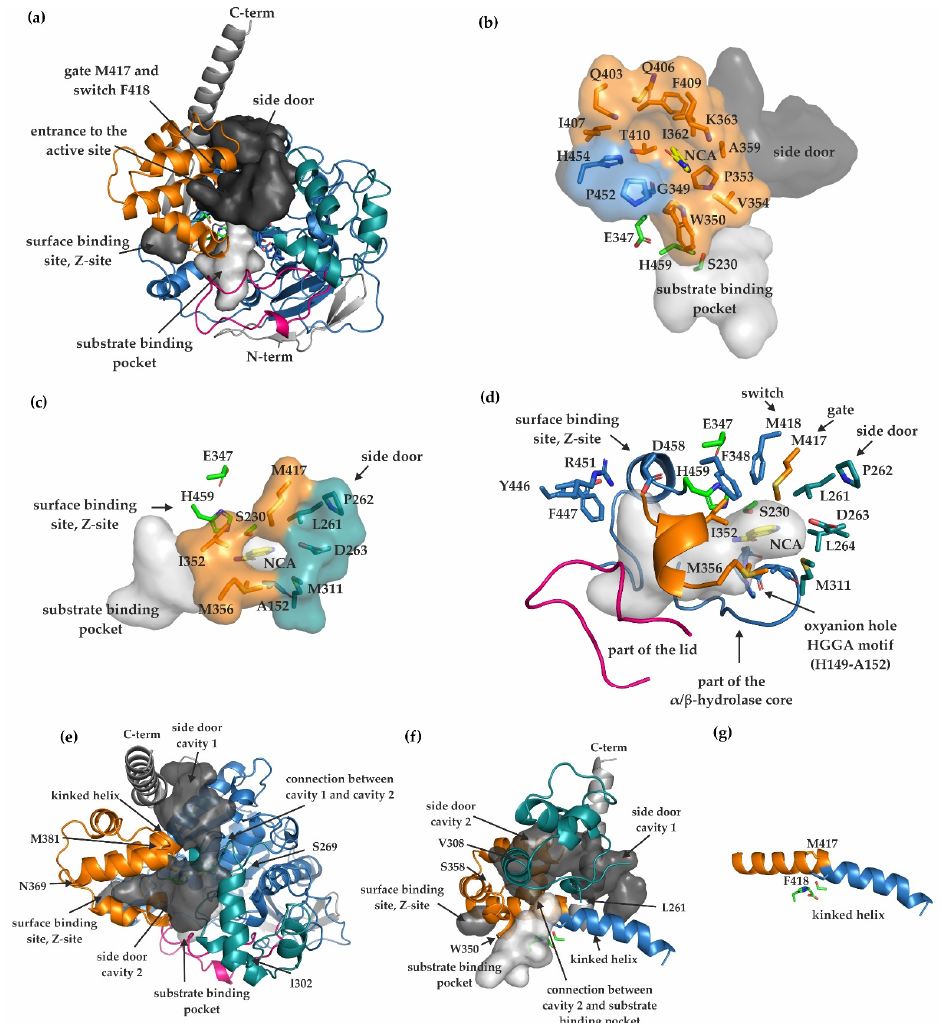
Figure 3. Binding pockets and conserved sites of mCes2c. ( a ) Substrate binding pocket (light gray), side door (dark gray) and surface binding site (Z-site, gray) are formed by mCes2c. The structure is shown in the same orientation as in Figure 2b. ( b ) Surface binding site (Z-site) of mCes2c (chain B) with residues sculpting the site colored according to their underlying modules (RD in orange, cap in teal, α / β -hydrolase core in blue). The active site residues are green and the nicotinamide (NCA) is in yellow. The molecule is oriented upon an approx. 90 degrees relative of 3a. ( c ) The entrance to the substrate binding pocket in surface representation is colored according to the underlying modules; residues lining the entrance are in sticks representation, A152 of the α / β -hydrolase core is in blue. ( d ) Substrate binding pocket (light gray surface) with residues lining the entrance in sticks. Other residues which form the substrate binding pocket are shown as sticks and cartoon, respectively (lid in pink, part of the RD shown in orange, and parts from the core are in blue). The NCA is yellow. The orientation of mCes2c is equivalent to Figure 3c. ( e ) Positioning of the side door (dark gray, surface representation) of mCes2c; RD in orange, cap in teal. ( f ) Positioning of the side door (dark gray, surface representation) and the connection between side door cavity 2 and the substrate binding pocket (light gray, surface representation). The kinked helix is indicated with an arrow. ( g ) The kinked helix represented as cartoon harbors the gate and switch residues M417 and F418, respectively. The catalytic residues (S230, E347, H459) are indicated as green sticks. The helix is presented in the same orientation as in Figure